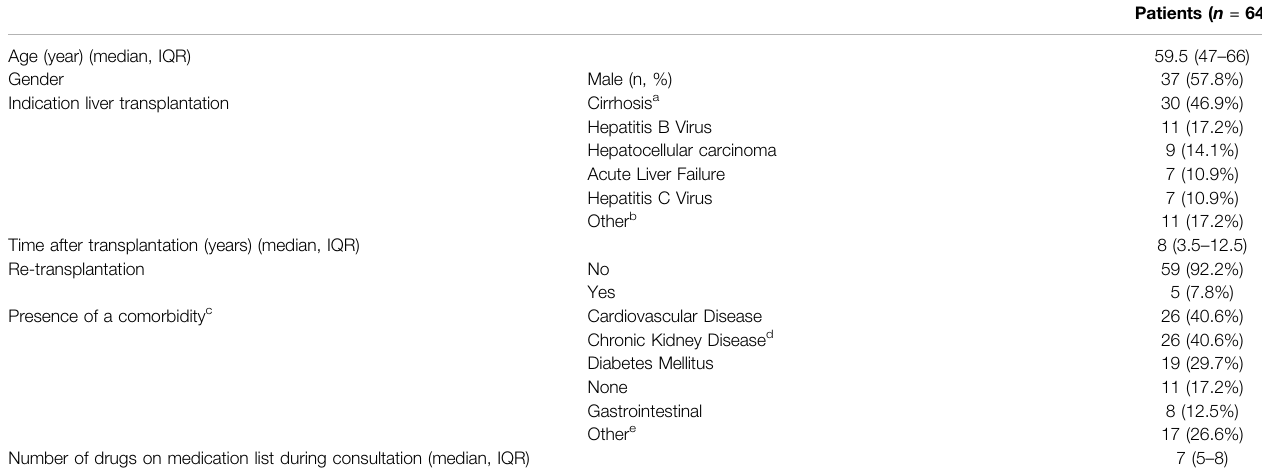
TABLE 1 | Clinical and demographical